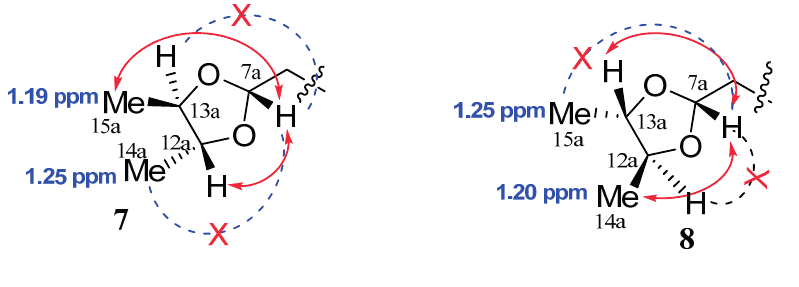
Figure 3. The NOESY correlations in 7 and 8